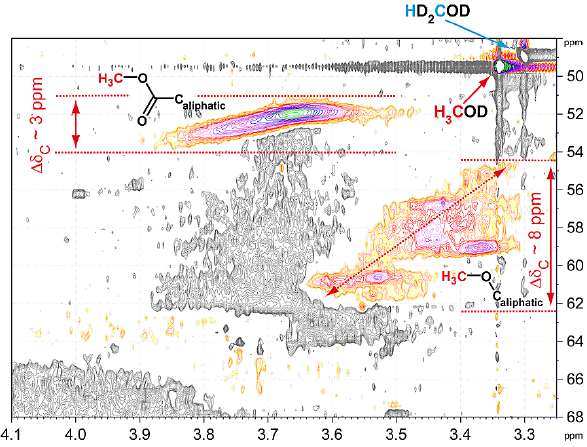
Fig. 8c. DEPT-HSQC NMR spectra of surface marine SPE-DOM at 5m. Section of H 3 C -O cross peaks with two major substruc- tures indicated: methyl esters and methyl ethers. Methyl ethers were more abundant than in freshwater and soil DOM and occu- pied a sizable range of carbon chemical shifts ( δ C : 55–62ppm), given the minimum distance of four bonds from the methyl pro- ton to the first optional variance in substitution ( 4 J ZH for H 3 C- O-C- Z (Z=C, O, (N, S)); likewise, the sizable spread of proton methoxyl chemical shift ( δ H : 3.35–3.65ppm) indicated substantial chemical diversity of methyl ethers found in marine SPE-DOM. The rather limited bandwidth of carbon chemical shifts in methyl esters ( 1δ C ∼ 3ppm) reflects the mandatory minimum distance of five bonds from the methyl proton to the first optional variance in substi- tution ( 5 J ZH for H 3 C-O-C(=O)-C- Z (Z=C, O, (N, S)); the sizable spread of proton chemical shifts ( δ H : 3.5–3.85ppm) nevertheless in- dicated substantial chemical diversity of methyl esters found in ma- rine SPE-DOM. Judging from the one-dimensional 1 H NMR spec- tra (Fig. 2d), the relative disappearance of the DEPT-HSQC methyl ether cross peak from surface to deep marine SPE-DOM (Fig. 7) likely reflected real disappearance of methyl ethers from surface to deep SPE-DOM rather than NMR relaxation imposed